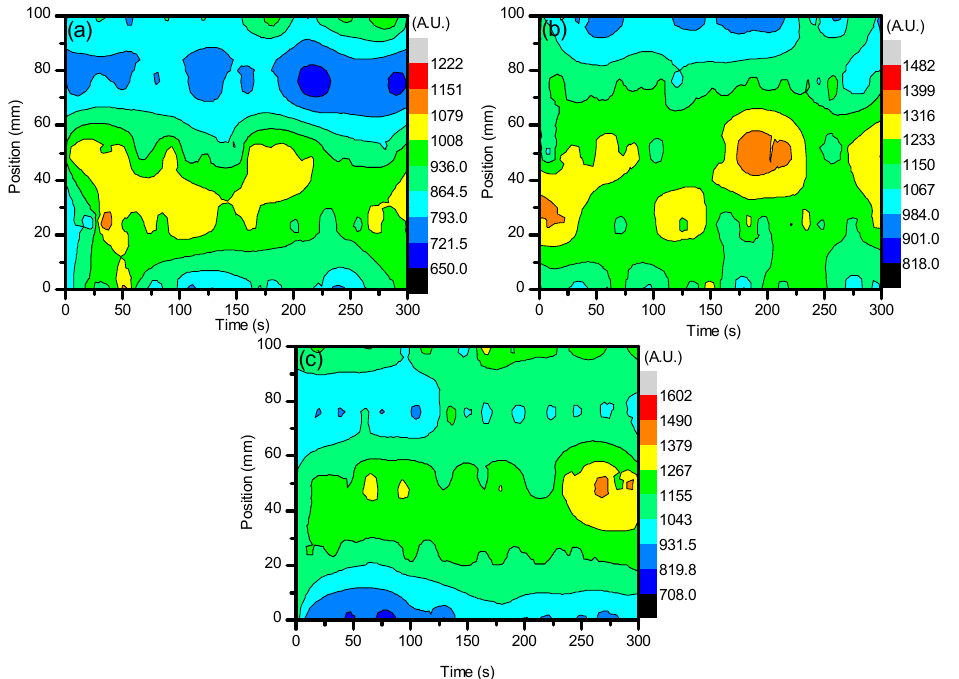
Figure 8. The formation of O I when the ambient air introduced to the system contained ≈ 3.8% CO 2 . ( a – c ) represent the applied voltages of 27 kV, 29.6 kV, and 32 kV